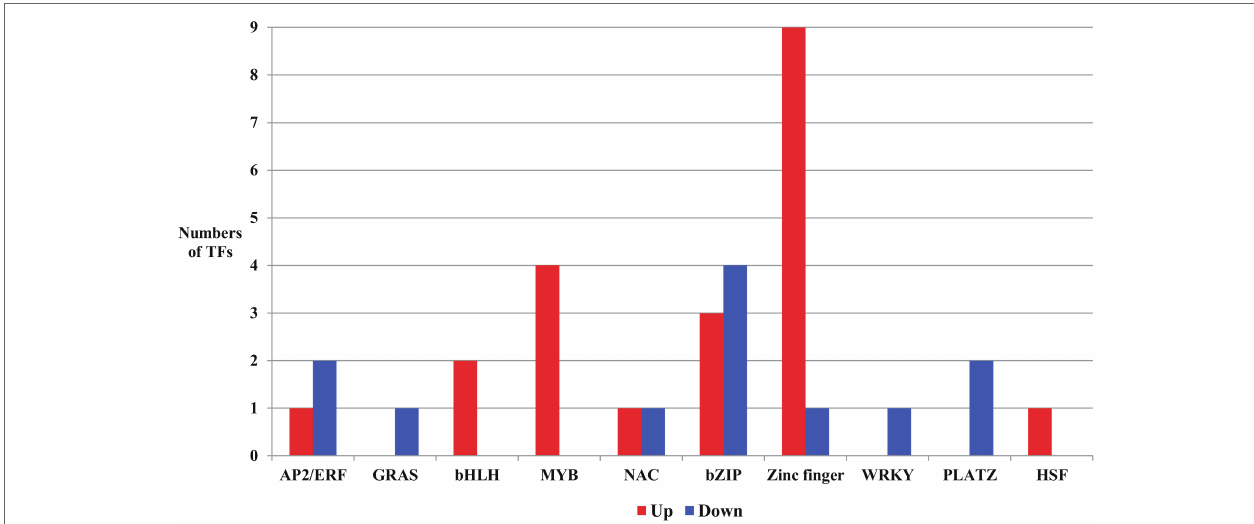
FIGURE 6 | Transcription factors (TFs) up or downregulated due to salt stress in the developing seeds of Samgwang. AP2/ERF: APETALA2/ethylene responsive factor; GRAS: GAI (Gibberellin-Acid-Insensitive), RGA (Repressor of GA1), SCL (SCARECROW); bHLH, basic helix-loop-helix; NAC: NAM, ATAF, and CUC; bZIP, basic region/leucine zipper; PLATZ, plant AT-rich sequence and zinc binding; HSF, heat shock